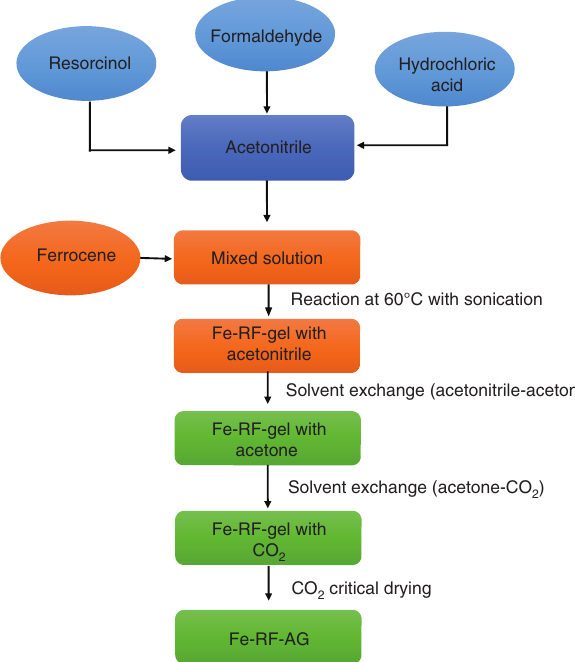
Figure 1 Schematic illustration of the synthesis of